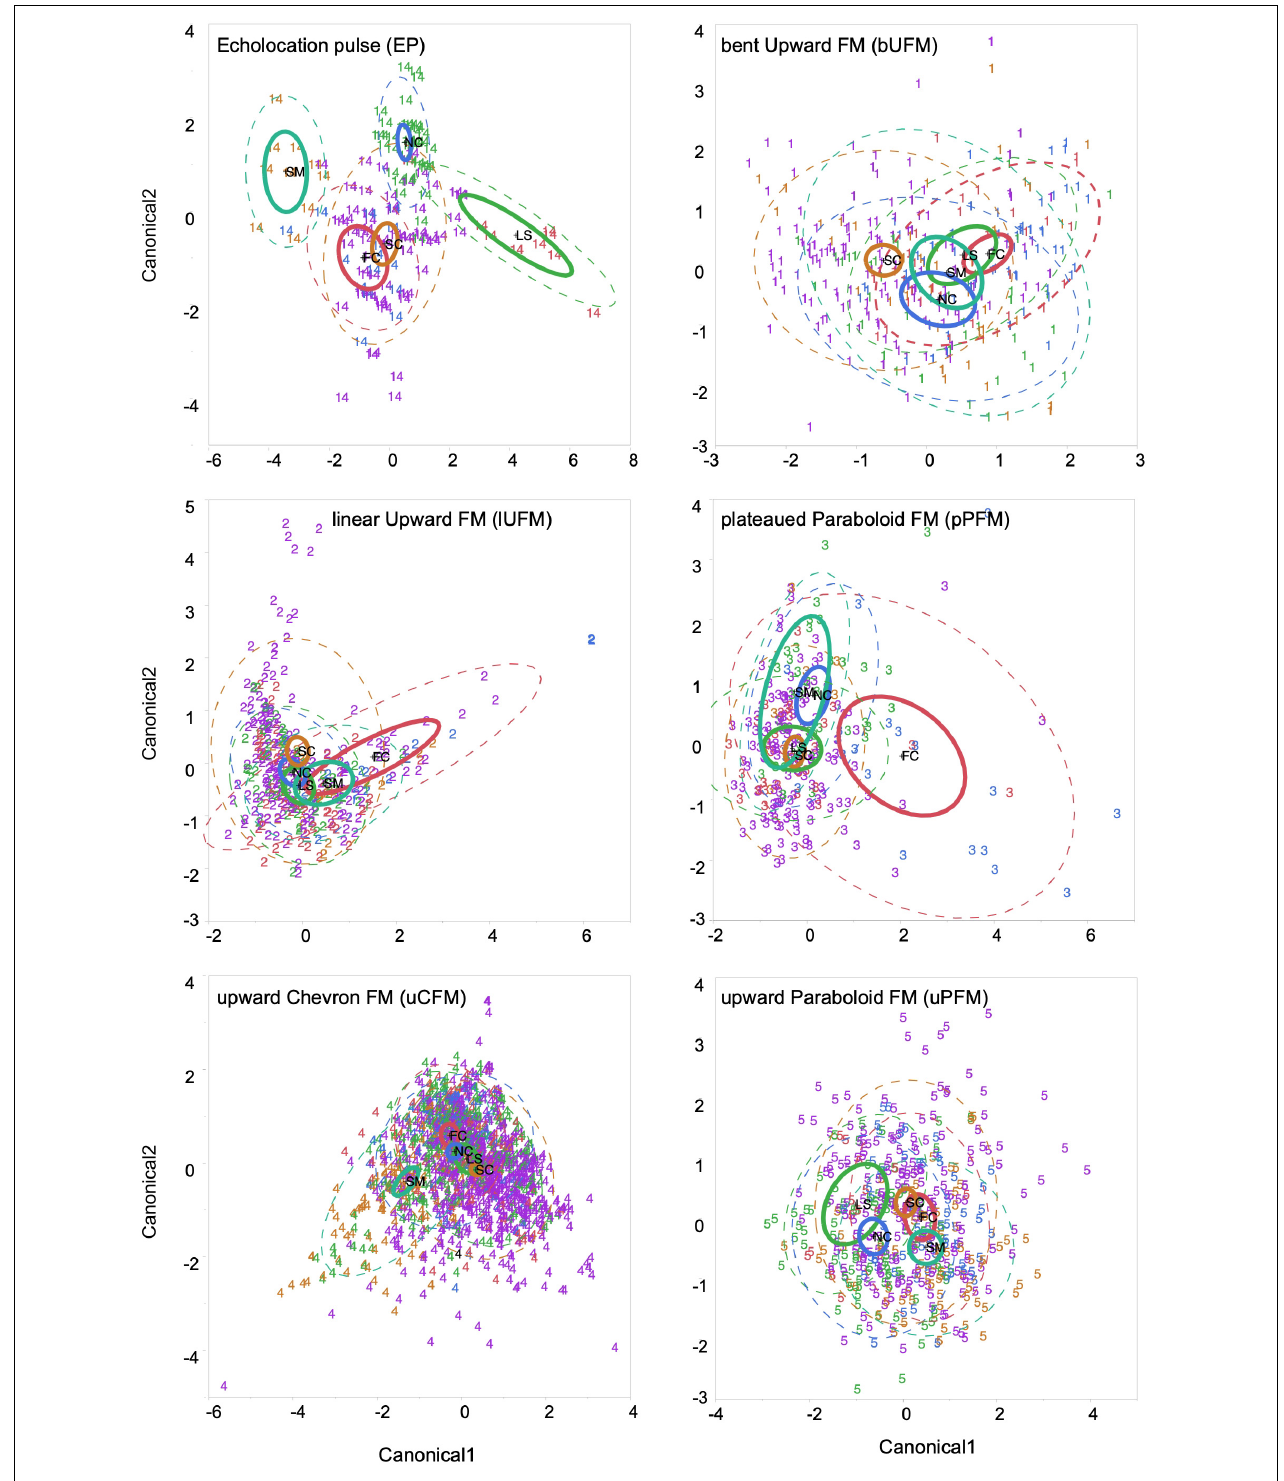
FIGURE 4 | Scatterplot of the first two canonical variables capturing the multiparametric variation for echolocation pulses and each of the five syllable types recorded for all geographic regions. The discriminant analysis tested for misclassification of observations for each geographic region. The point corresponding to each multivariate mean is denoted by a plus (“ + ”) marker. Bold lines denote the 95% confidence ellipses and dashed lines indicate boundaries containing ∼ 50% of the observations. Echolocation pulses and three syllables show good separation between FC (red ellipses) and SM regions (bluish-green ellipses).